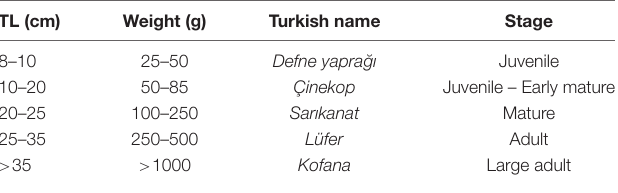
TABLE 4 | Turkish common names for bluefish ( Pomatomus saltatrix ) according to size (Türgan, 1957, 1959) and stage (Ceyhan et al.,